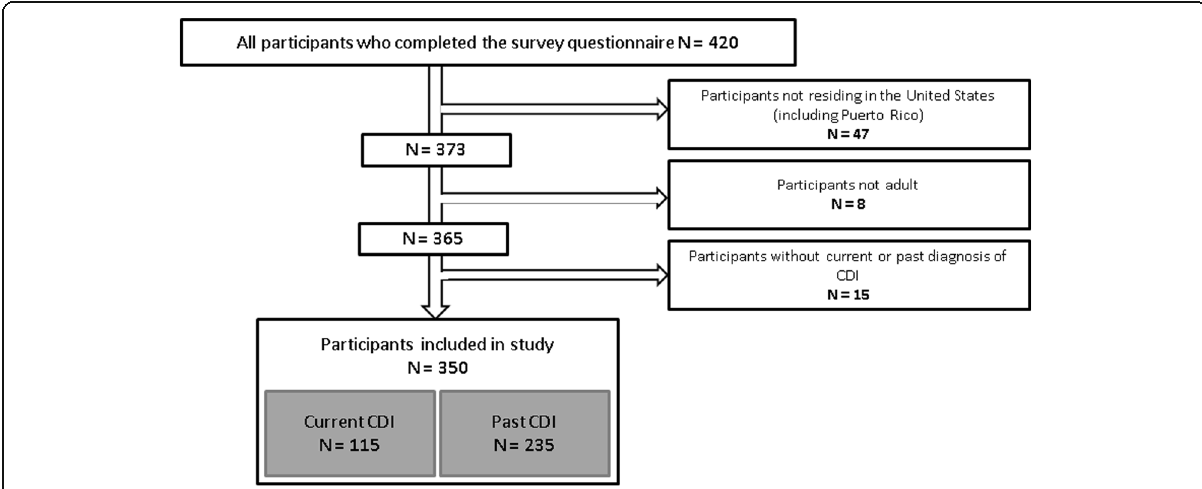
Fig. 1 Construction of the study